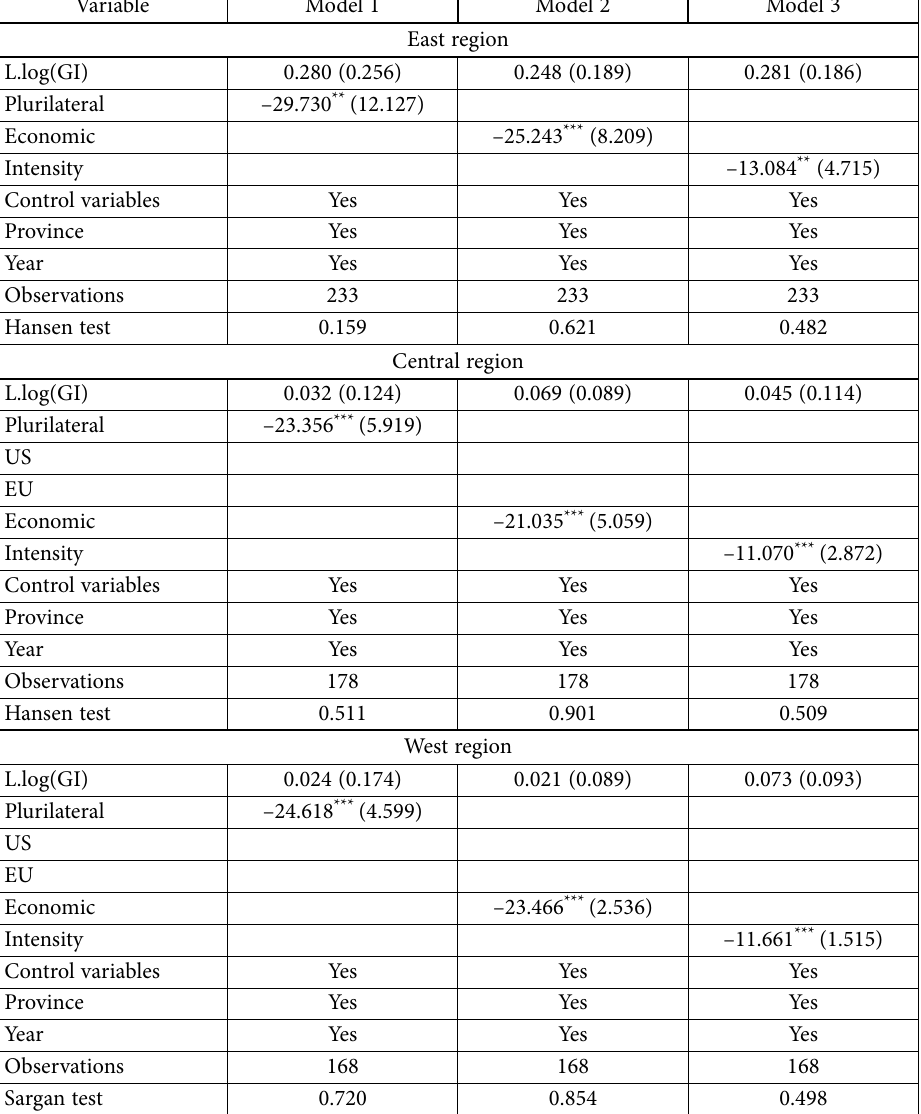
Table 2. Estimation results of the GMM model for different